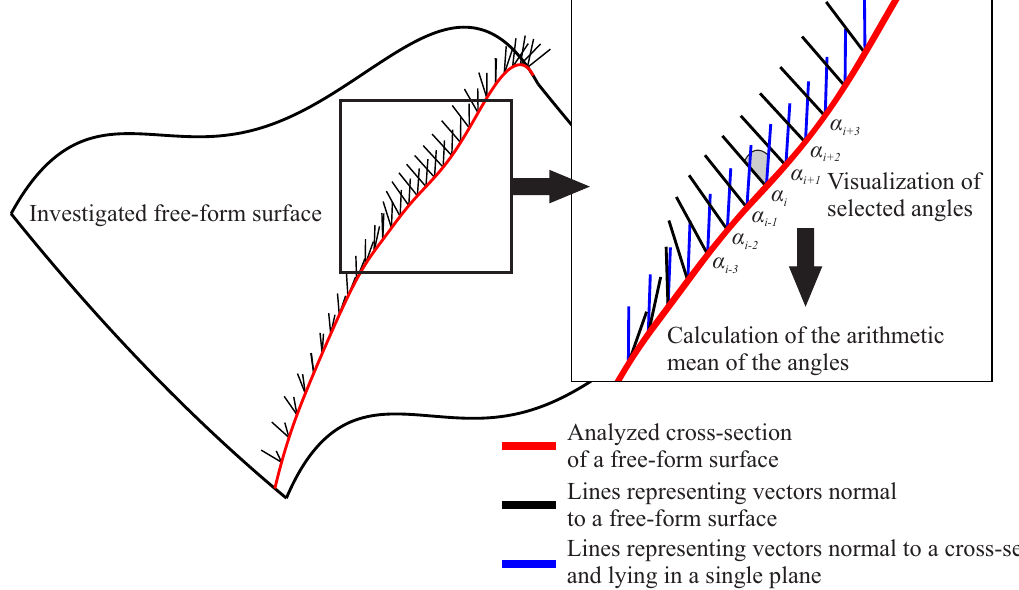
Figure 3. The calculation of the deviation of the selected cross-section from the 2D curve based on the arithmetic mean of the angles between normal